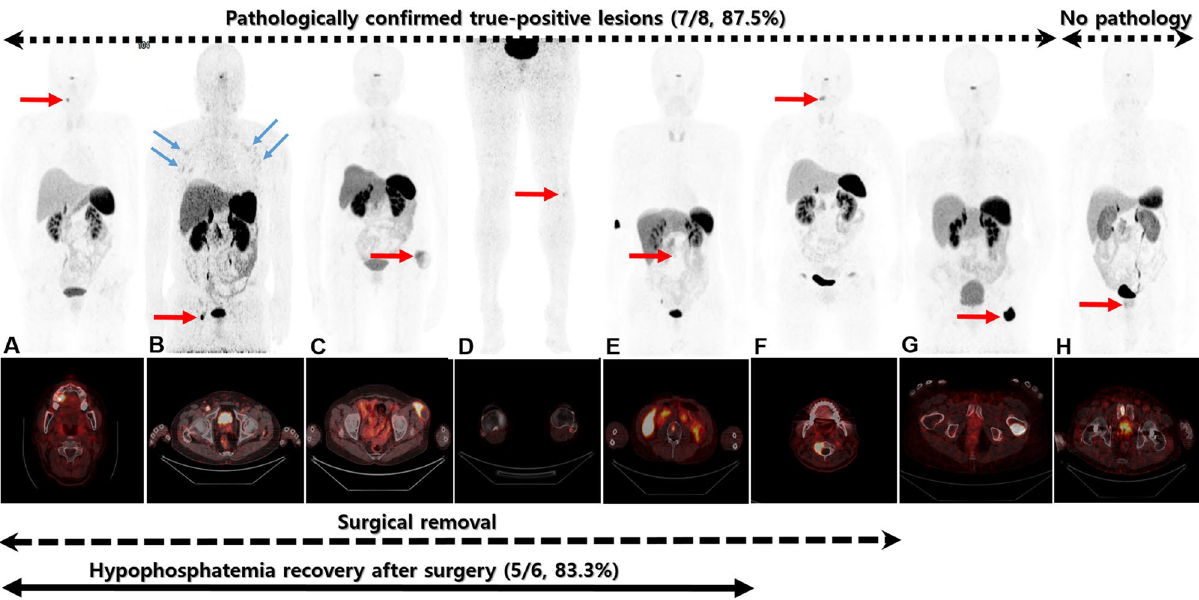
Figure 1. Maximum intensity projection (MIP) images and axial PET/CT images of eight patients with positive lesions according to the 68 Ga-DOTATOC PET/CT. The red arrows in the MIP images indicate causative lesions in the corresponding PET/CT image, whereas the blue arrows in ( B ) indicate non-pathognomonic uptake. ( A ) Lesion in the right maxilla with SUV max : 12.7. ( B ) Lesion in the right inguinal lymph node with SUV max : 24.0. ( C ) Lesion in the left thigh with SUV max : 9.9. ( D ) Lesion in the left fibula with SUV max : 1.9. ( E ) Lesion in the L3 body with SUV max : 4.5. ( F ) Lesion in the C2 body with SUV max : 10.7. ( G ) Lesion in the left femur with SUV max : 45.7. ( H ) Lesion in the right pubic bone with SUV max :